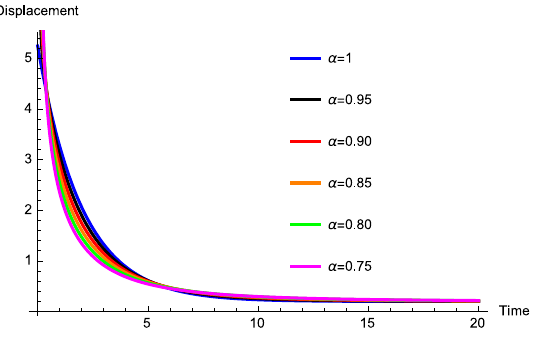
Figure 8. Numerical simulation for Equation (42) considering different values of α , arbitrarily chosen.